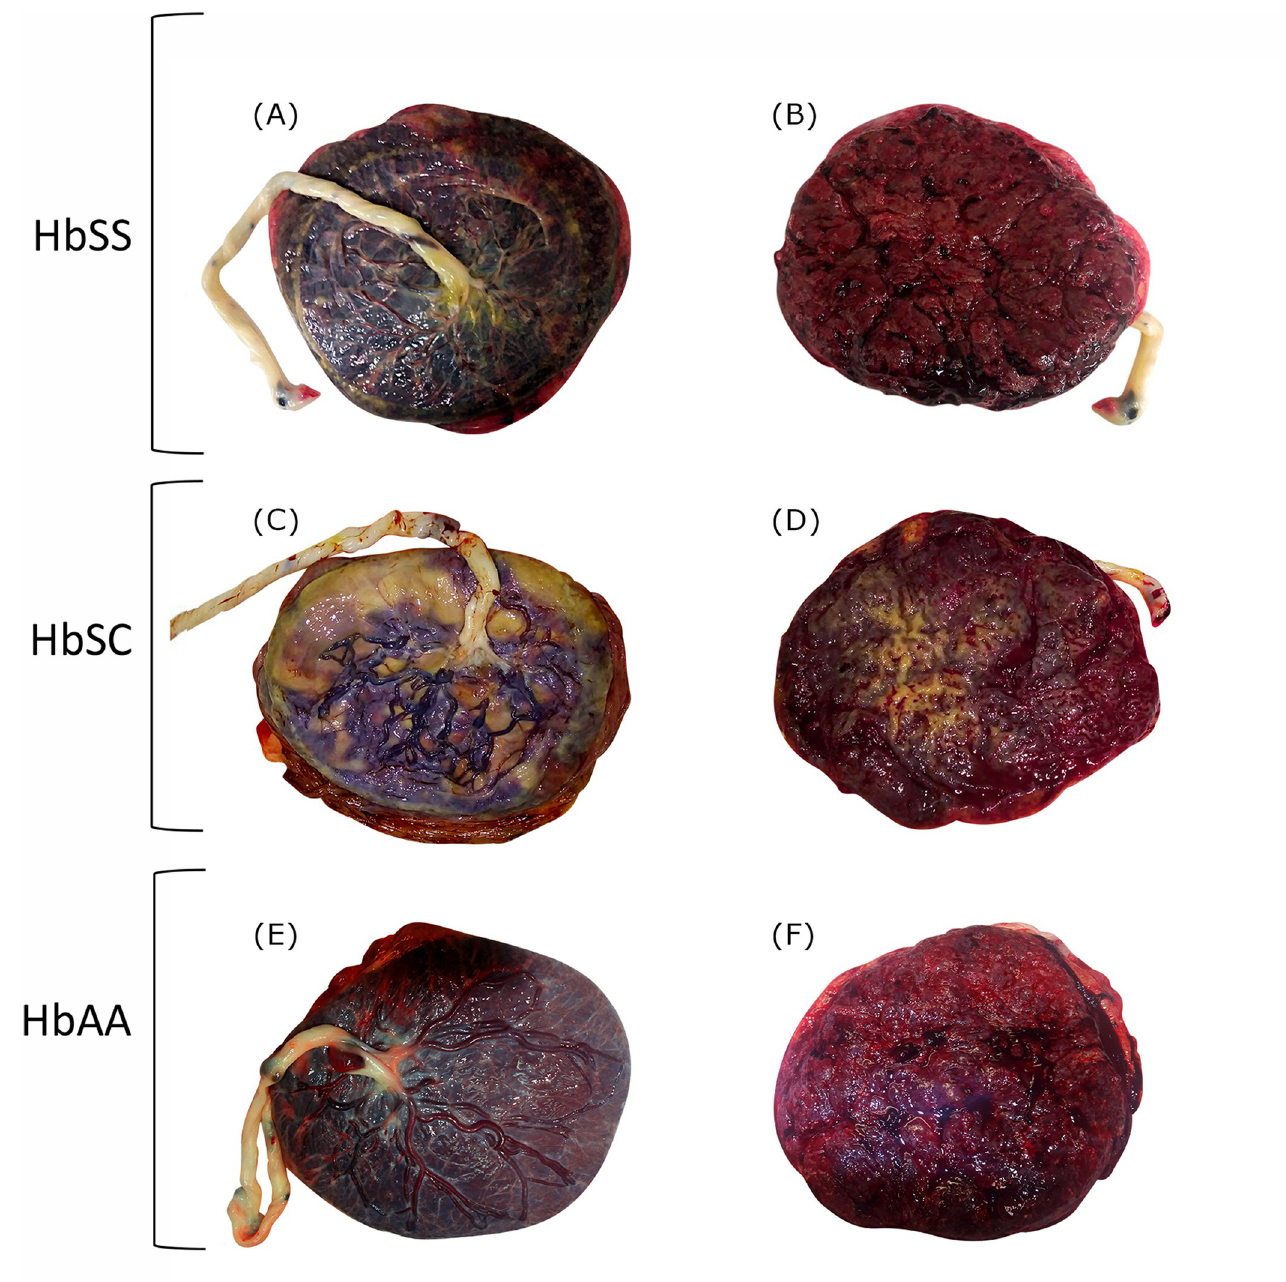
Fig 1. Gross evaluation of one selected placenta from each of the three groups of patients considered: HbSS, HbSC and HbAA (without SCD). Fetal (A) and maternal (B) sides of the placenta from a HbSS patient with a term cesarean delivery (37 week gestation) with multiple hospital admissions for worsening anemia and previous exchange transfusion at 28 weeks. Fetal (C) and maternal (D) sides of the placenta from a HbSC patient, also delivered by cesarean at term, due to maternal request (37 weeks) with programmed blood transfusions during third trimester and no severe complications. Fetal (E) and maternal (F) sides of the placenta from a patient without SCD, delivered at 39 weeks, by Cesarean section due to 2 previous cesareans. In the HbSS and HbSC placentas it is possible to observe increased subchorionic fibrin deposition and calcifications (non-specific alterations). For methylation analysis, villous tissue was sampled.